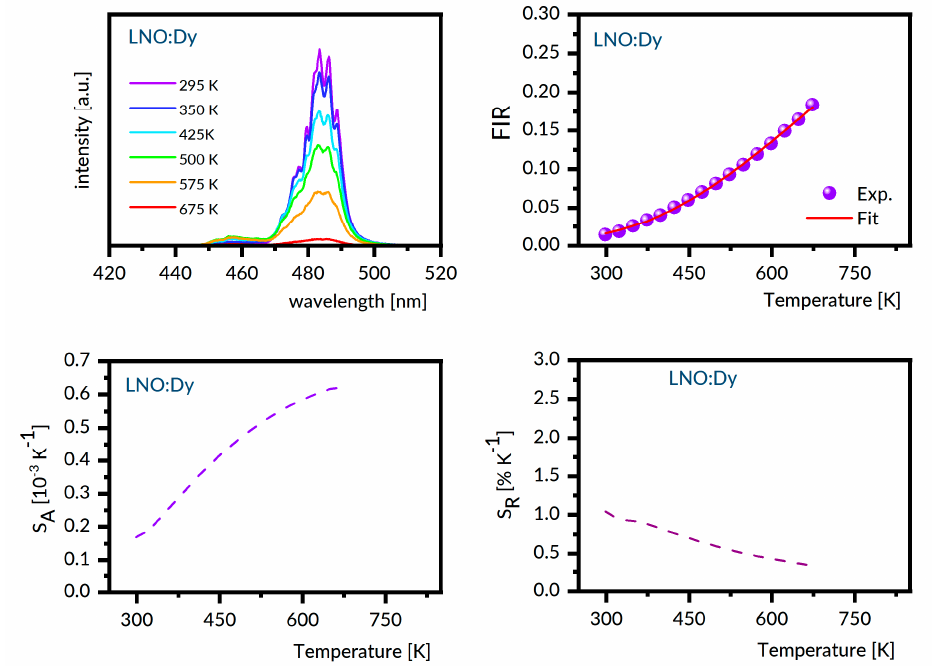
Figure 8. LNO:Dy emission spectra recorded at several different temperatures ( upper left ), the plot of FIR versus temperature ( upper right ), the temperature dependence of S A ( lower left ), and the temperature dependence of S R ( lower right ).